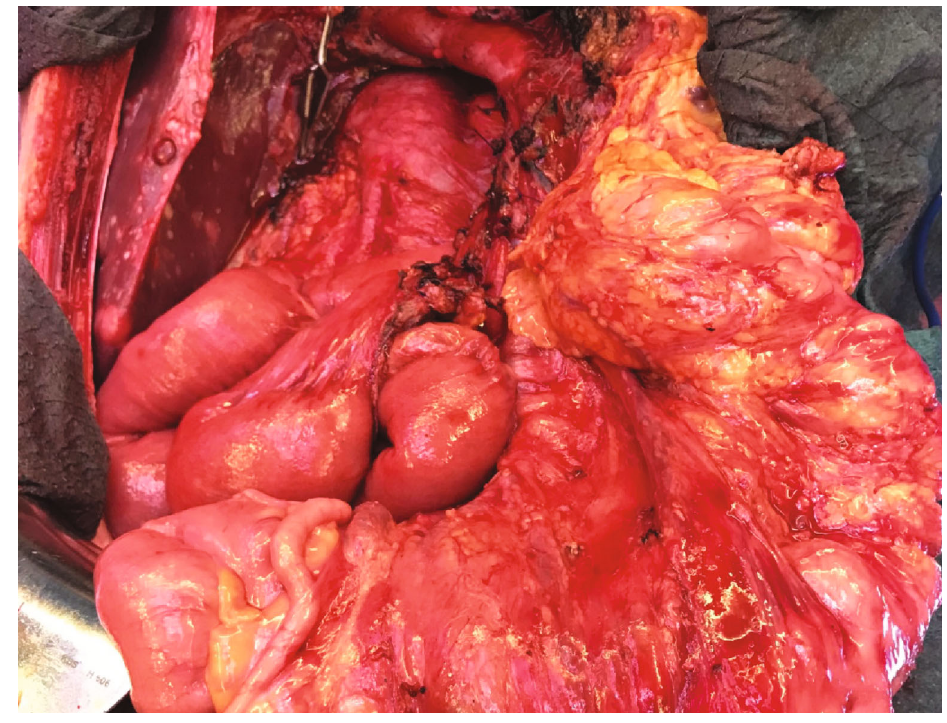
Figure 8: Situs after resection.